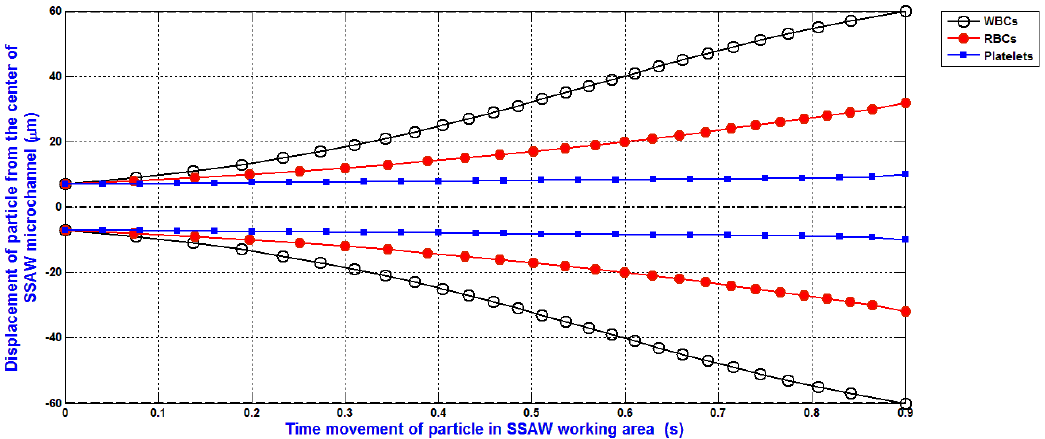
Figure 9. The separation of blood components based on the design analysis of SSAW microfluidics and the analysis of SSAW force with Rayleigh angle effect and its attenuation in liquid-loaded substrate, viscous drag, hydrodynamic, and diffusion forces.